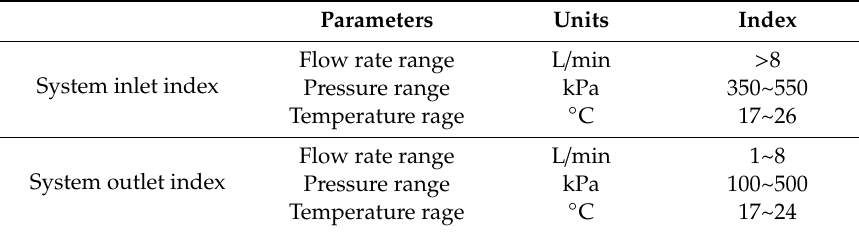
Figure 6. Flow Path Structure Dimensions and Five Ridge Profiles. Table 1. Liquidlens TM LLG4 System Flow Parameter Index.